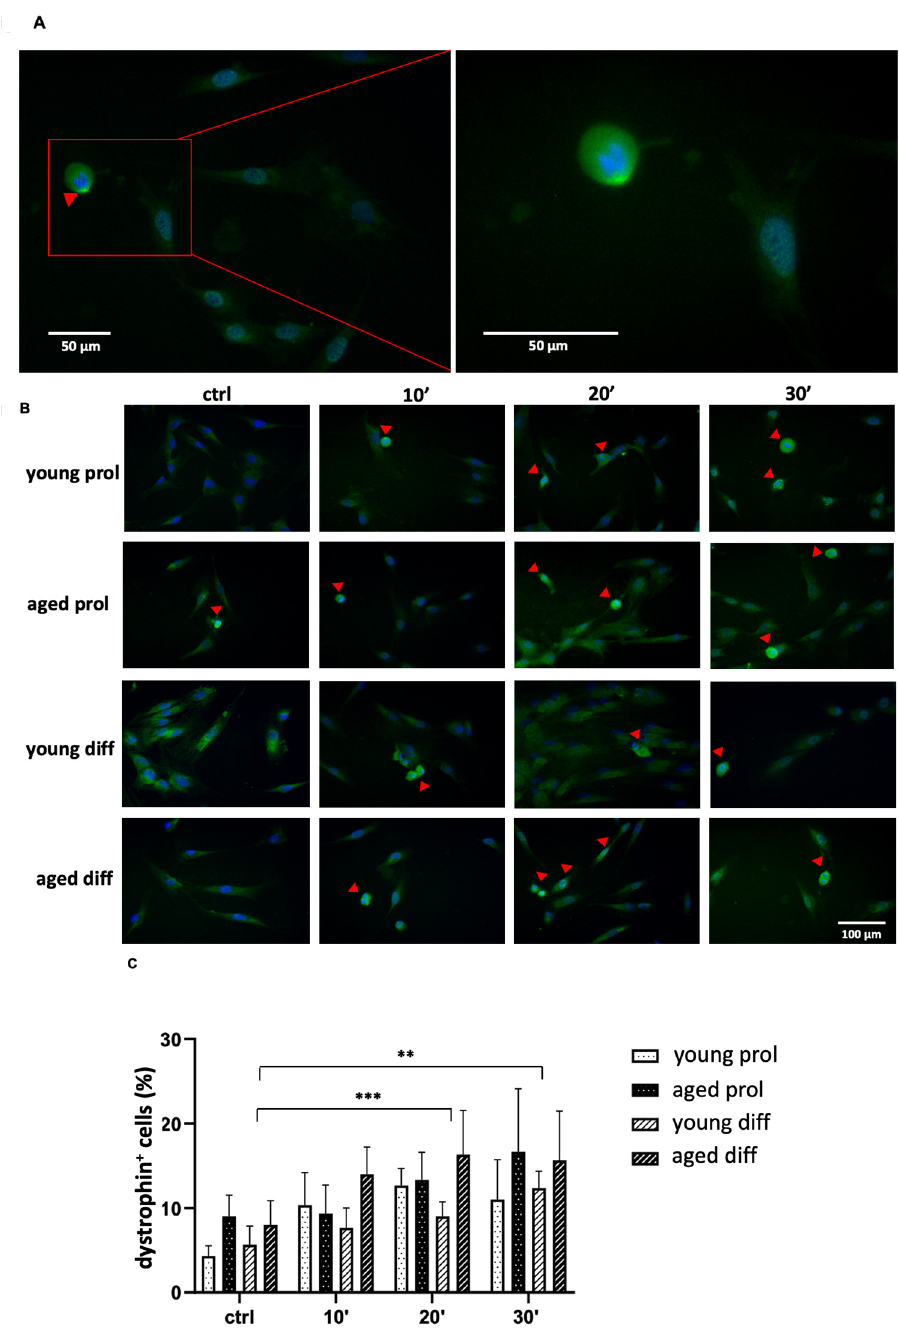
Figure 8. Effect of ViSS treatment on SC activation. ( A ) Green-fluorescent dystrophin-positive acti- vated cell (red arrow). ( B ) Representative fields from both age groups, with red arrows pointing at dystrophin-positive activated cells. ( C ) Percentages of dystrophin-positive activated cells in both age groups. Data are expressed as mean ± SEM of three independent experiments ( n = 3). Activated cells were scored out of a total of 39–148 cells for each experimental group. Significance was deter- mined with two-way ANOVA test, followed by Tukey’s multiple comparison test (main row effect). ** p ≤ 0.005, *** p ≤ 0.001.